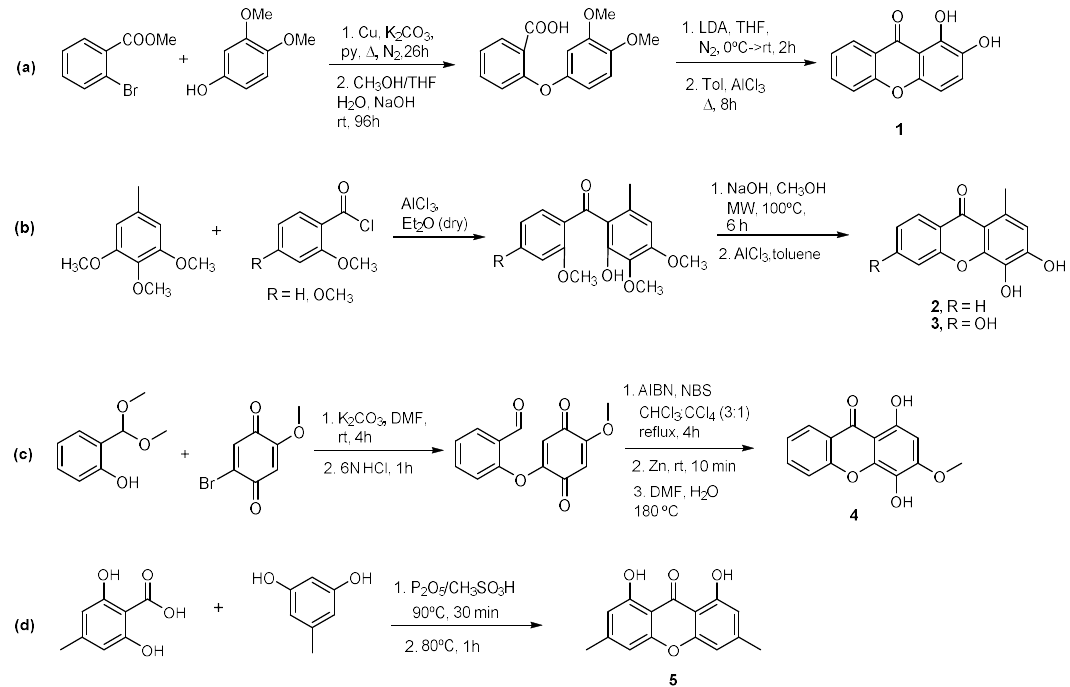
Table 1. DPPH scavenging activity at 25 µM (mean value and standard deviation) and IC 50 values of the tested compounds and ascorbic acid as positive